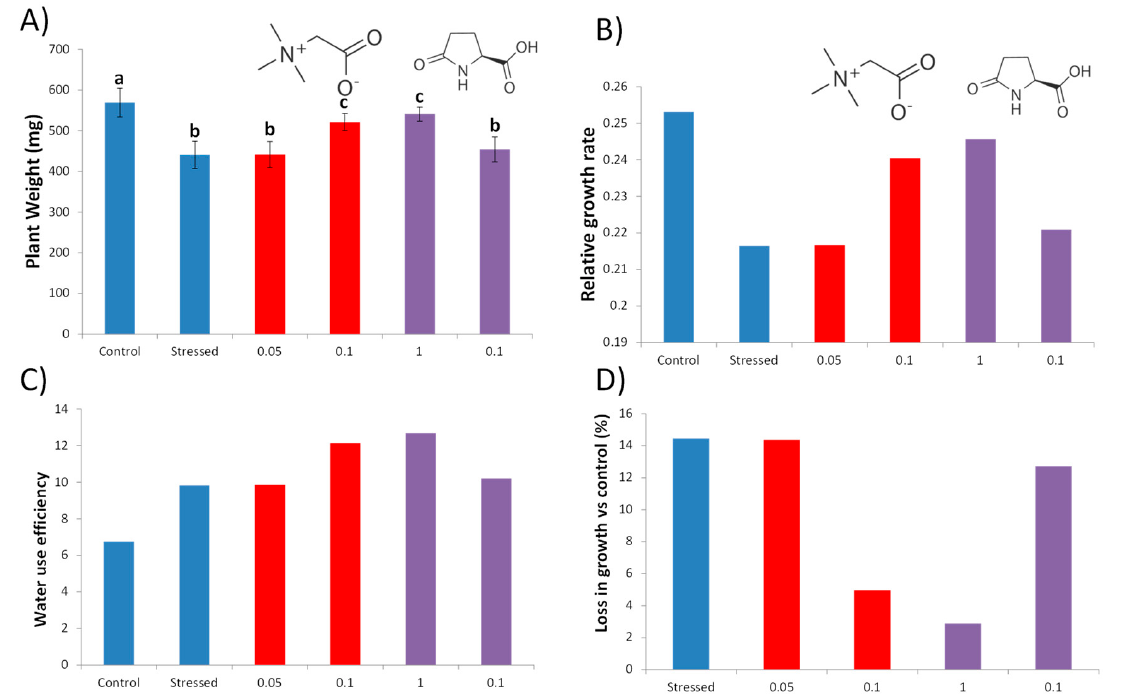
Figure 2. Soil dosage evaluation using 50% less water as a stressor. Red and violet correspond to GB and PG treatment, respectively. Plant weight in mg. ( A ) Relative growth rate. ( B ) Water use efficiency. ( C ) Percentage growth loss against control. ( D ) Bars labelled with the same letter did not show significant differences at p < 0.05.